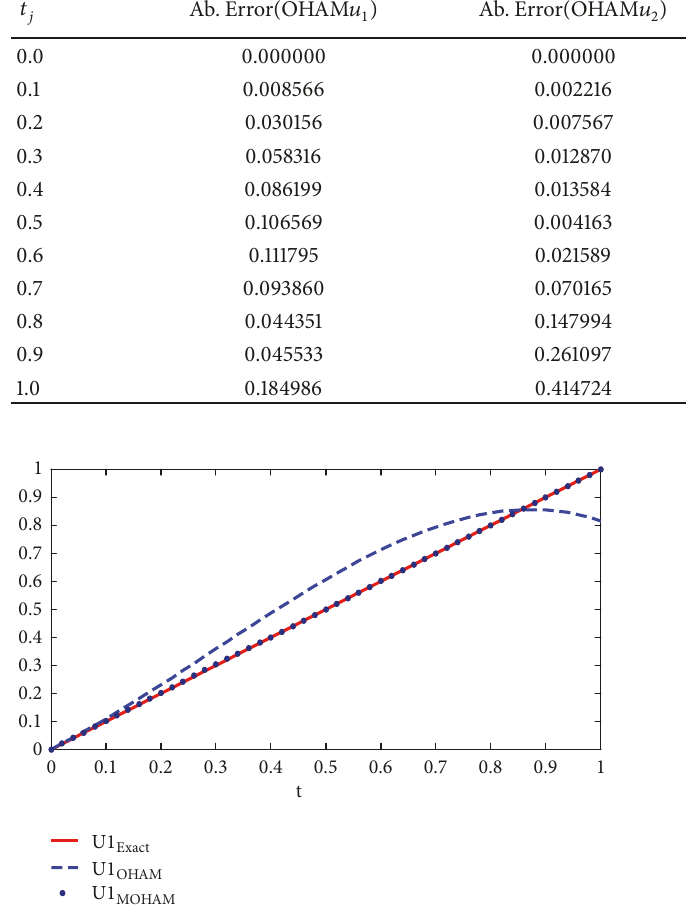
Figure 5: The results of OHAM, MOHAM, and exact solution for u1 in Example 2.